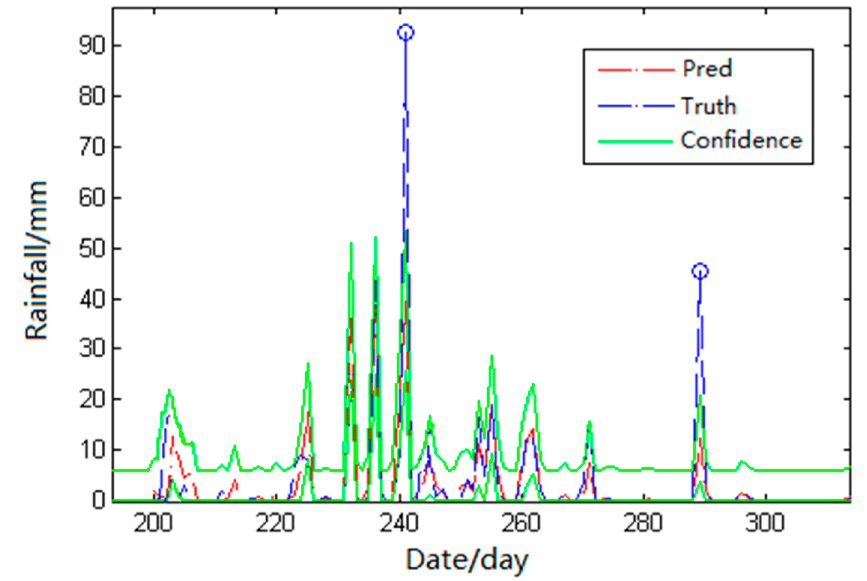
Figure 19. Suspicious data detection of rainfall in Tang Yin from June to September in 2007.